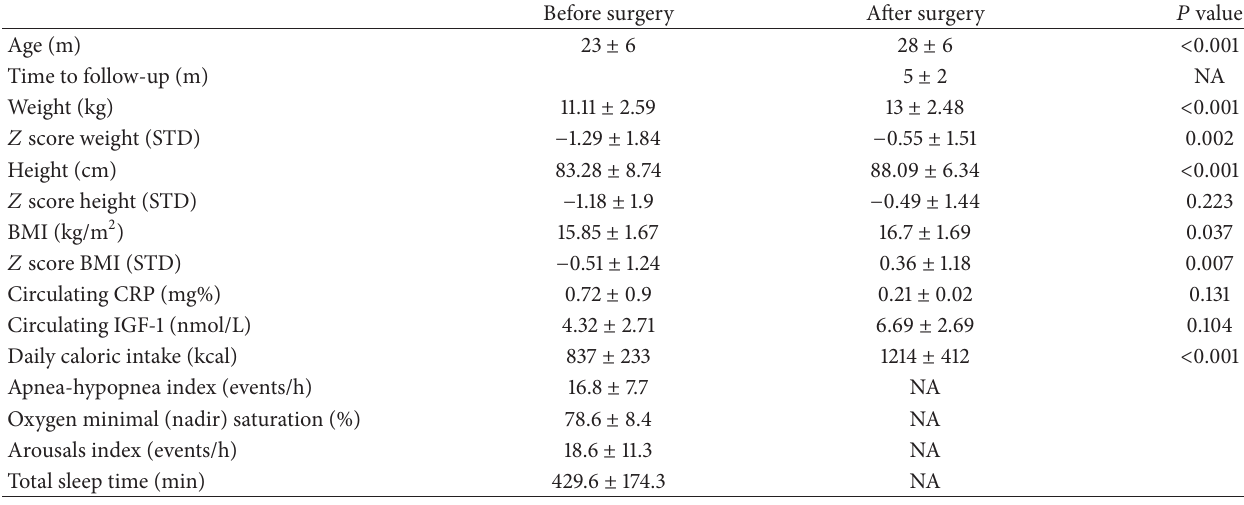
Table 1: Pre- and postsurgery characteristics.